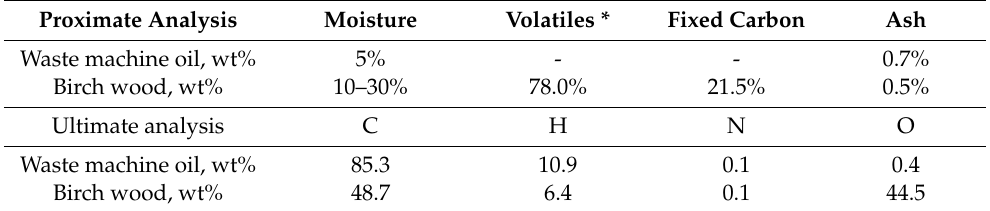
Table 2. Proximate and ultimate analyses of waste machine oil and birch wood. Proximate Analysis Moisture Volatiles * Fixed Carbon Ash Waste machine oil, wt% 5% - - 0.7% Birch wood, wt% 10–30% Ultimate analysis C